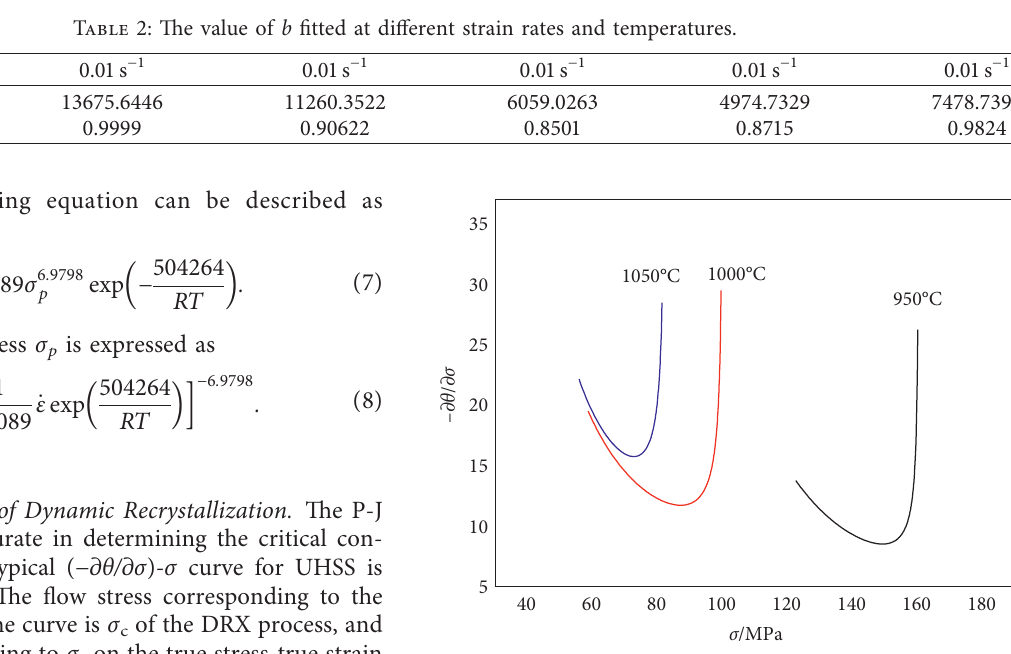
Figure 7: Plots of (− z θ / z σ ) and σ